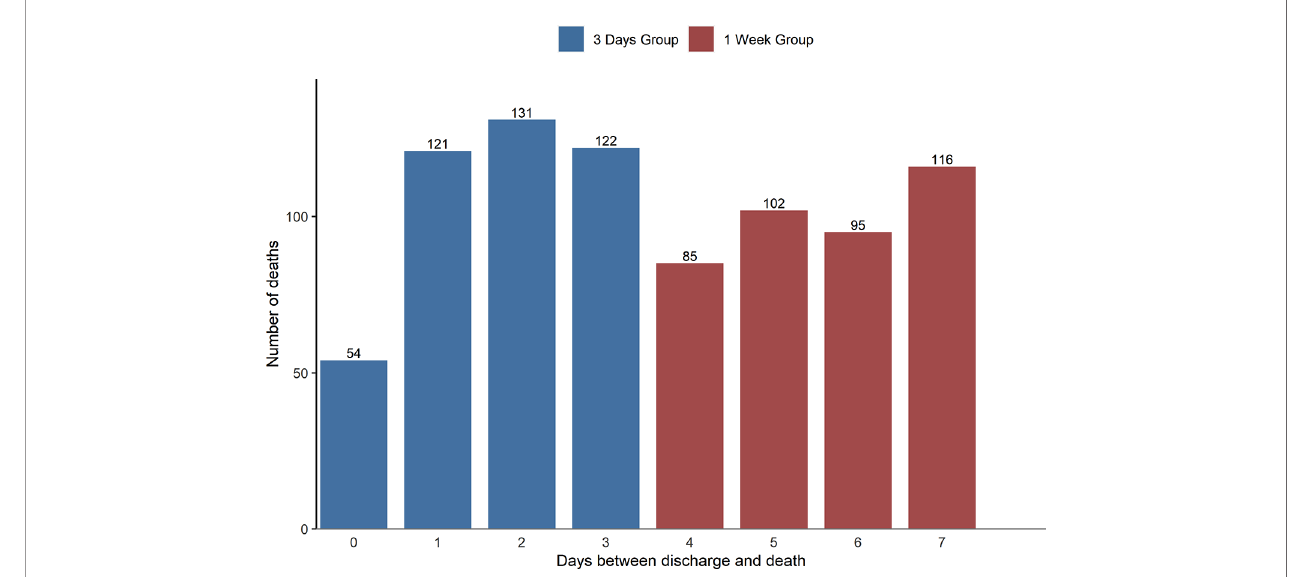
FIGURE 1 | Frequency of deaths by suicide in England and Wales between 1st January 1997 until 31st December 2016 by discharge day ( N =